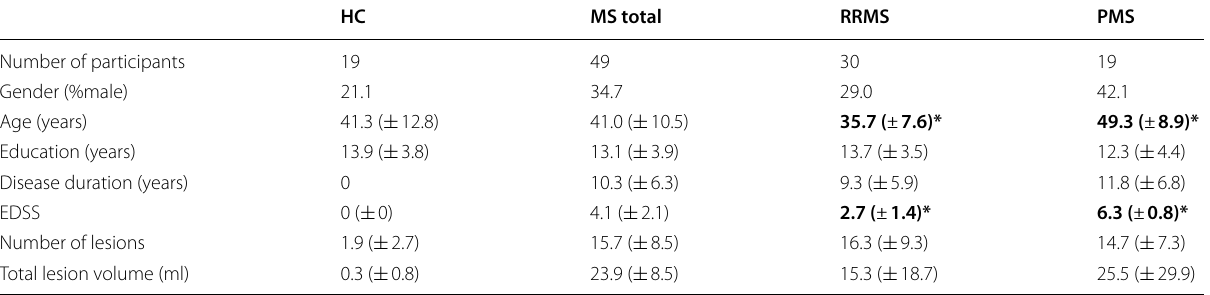
Table 2 Study population characteristics. Age, education, disease duration, EDSS, amount of lesions, lesion volume are presented